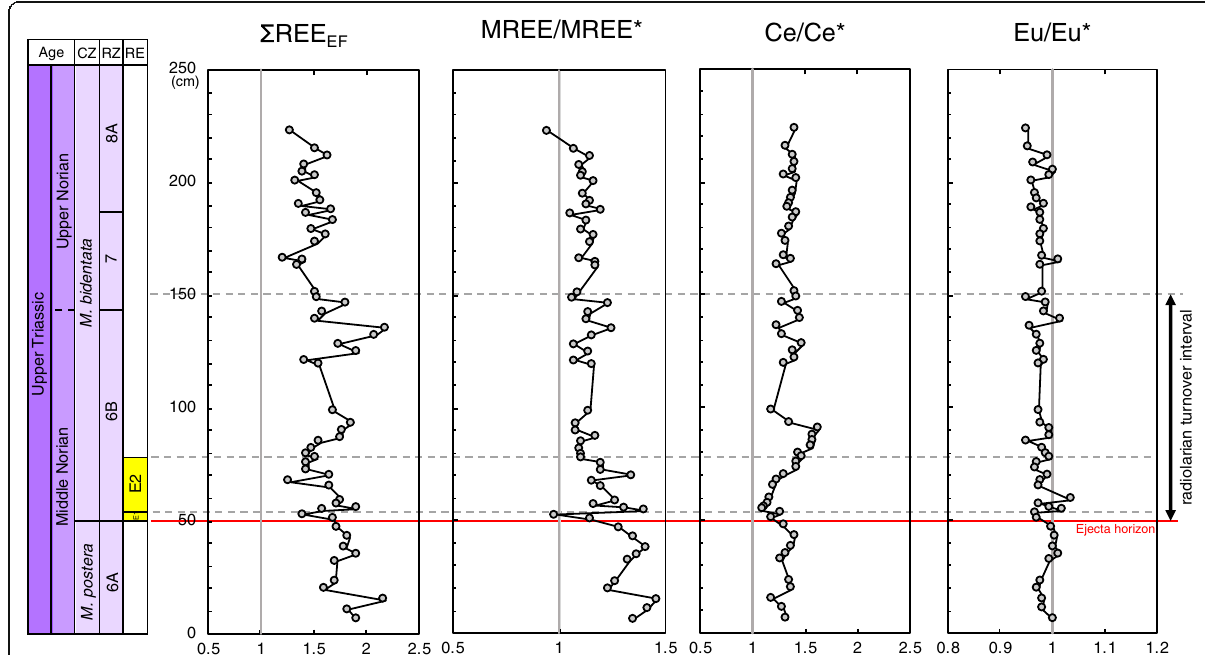
Fig. 11 Stratigraphic profiles of ∑ REE EF , MREE/MREE*, Ce/Ce*, and Eu/Eu* in the studied section. Enrichment factors (EF) were calculated relative to UCC (Rudnick and Gao 2014). SiO 2 -poor parts of claystone samples (NH52-R2, -R3, -R5, and -R7) are excluded from the stratigraphic